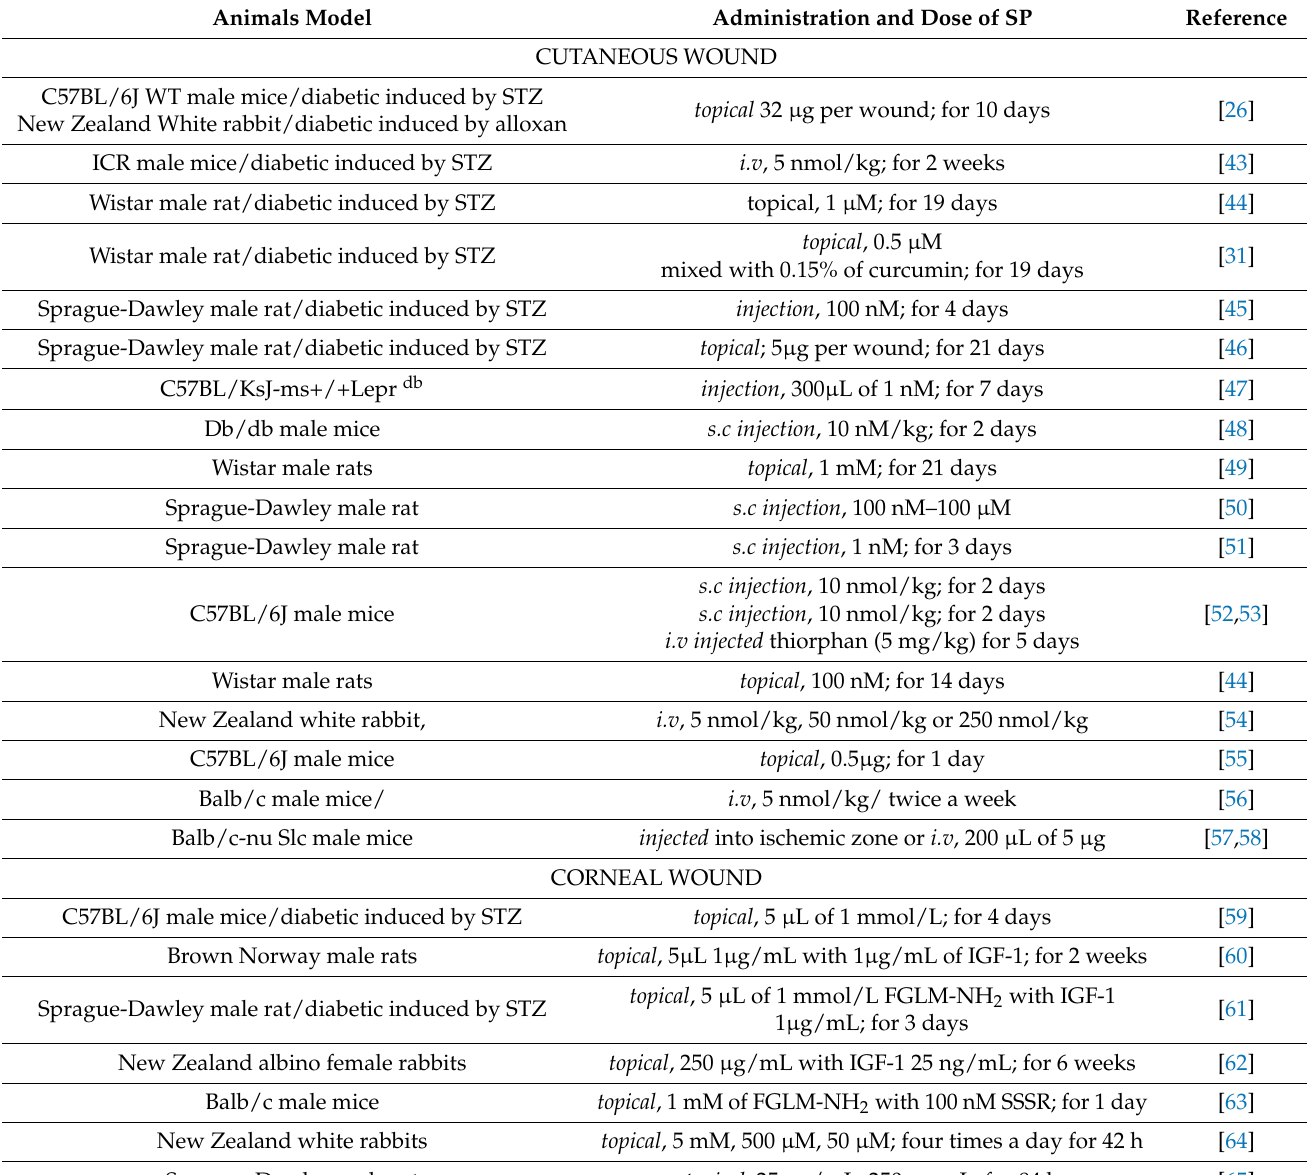
Table 1. The different types of animal wound healing models used to study the effect of substance